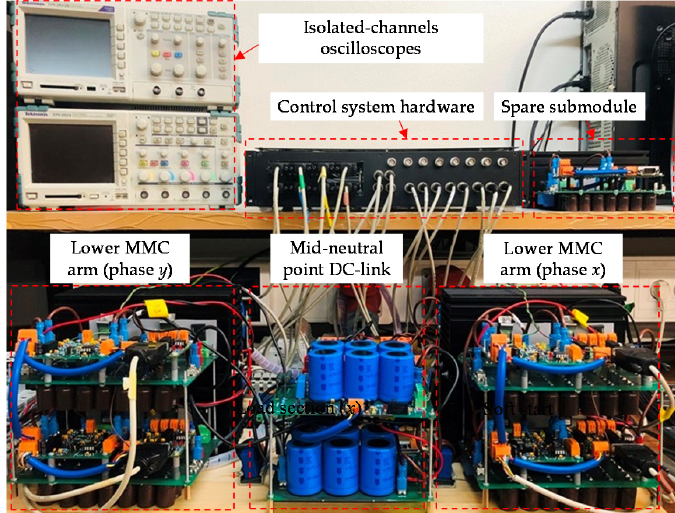
Figure 16. Workbench with the developed modular multilevel converter